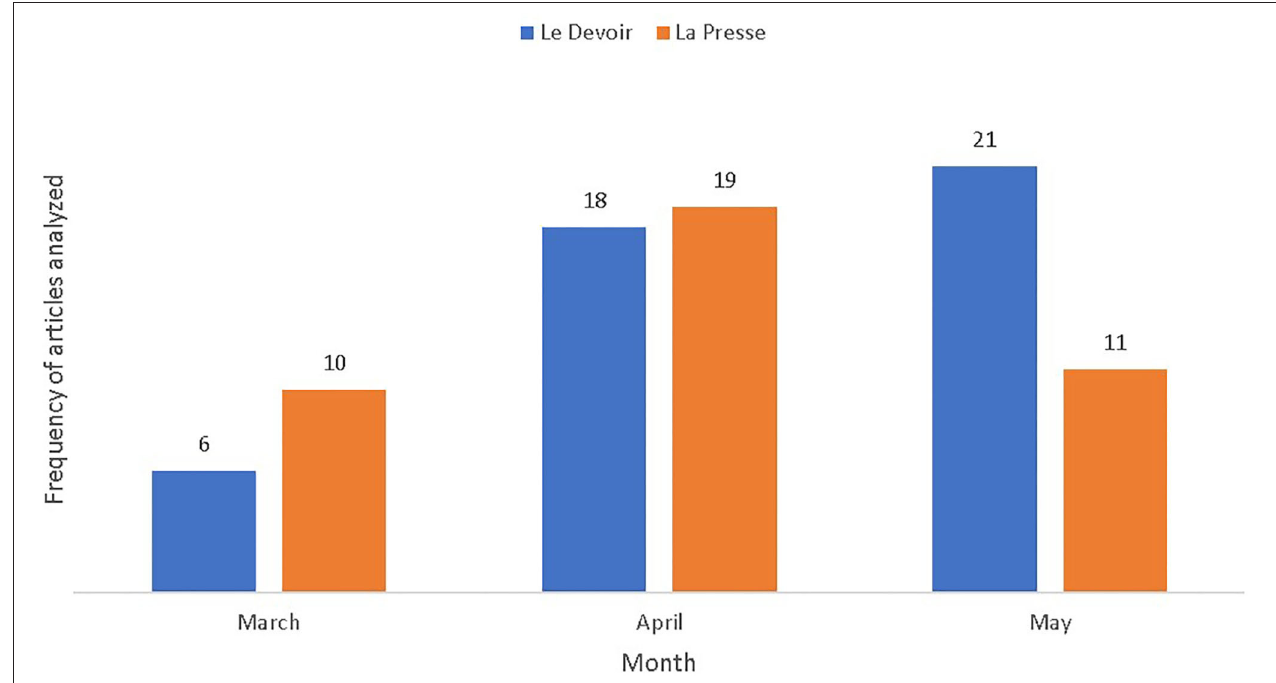
FIGURE 1 | Distribution of articles analyzed by each journal across